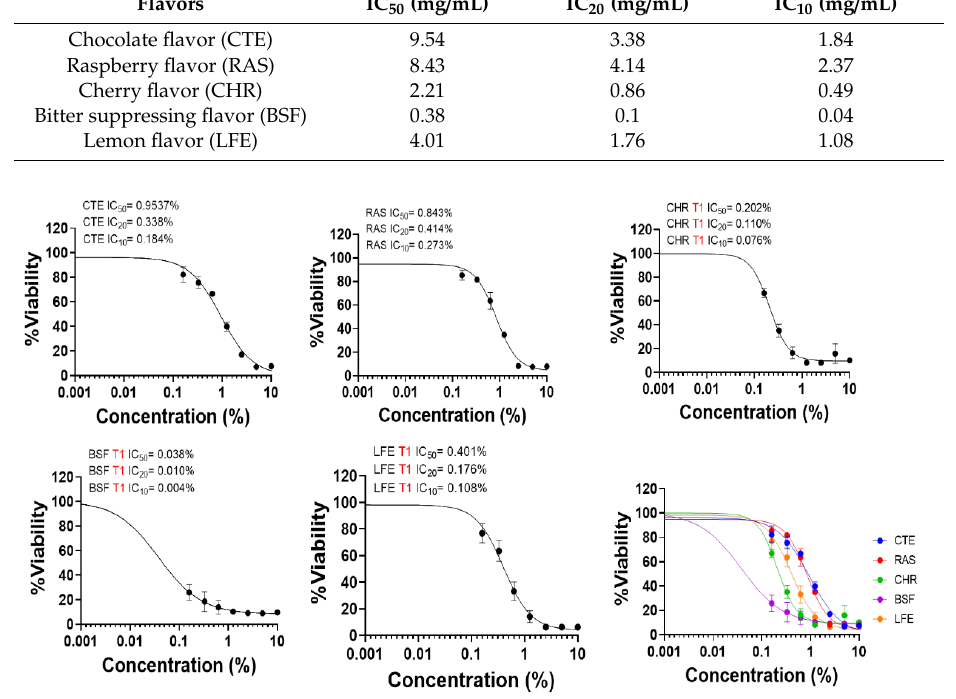
Figure 1. Dose–response curves of selected flavors via MTT proliferation assays in human primary gingival keratinocytes.